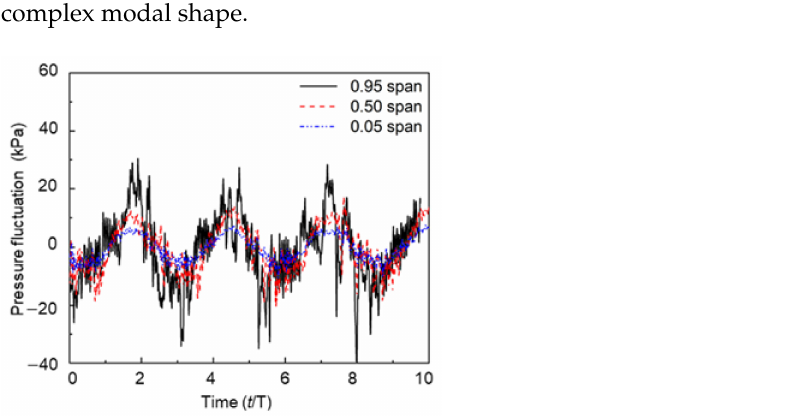
Figure 15. Unsteady pressure fluctuations at the leading edge of TVD ( ϕ = 0.7 Q d ). To investigate the evolution of vortices near the diffuser entrance as the stall cell propagates, the instantaneous vortex structures and limiting streamlines were examined, as shown in Figure 16. In these figures, vortex structure behaviors are visualized with Q -definition and colored by nondimensional helicity. At time t = t 0 , near the suction surface of the right diffuser vane, only the clockwise-rotating transverse vortex I (Figure 13) is found. Besides, two centers of vortices appear near the suction surface of the vane leading- edge. The counterclockwise-rotating transverse vortex II (in Figure 13) appears at time t = t 1 . Meanwhile, two centers of vortices appearing at time t = t 0 are merged, making the shroud-side flow more disordered. When the impeller runs to t = t 2 , the transverse vortex II generated from the right diffuser vane increases in size due to the high adverse pressure gradient. The transverse vortex II then moves toward the leading edge of the adjacent left vane and blocks the throat of the diffuser. Note that the flow near the shroud side and leading edge of the right diffuser vane is more disordered, and the flow separation region occupies one-third of the suction surface of the whole vane at time t = t 2 .